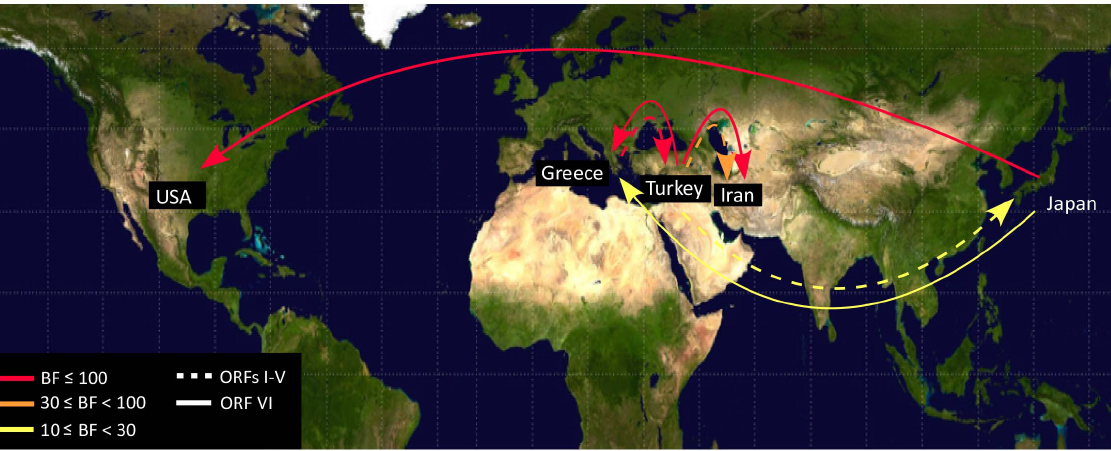
Figure 4. Patterns of Cauliflowermosaicvirus migration jointly estimated across the two ORF regions. ORFs I–V and ORF VI migrations are shown by solid and dashed lines. Lines connecting discrete regions indicate statistically supported ancestral state changes and their thicknesses denote statistical support. There are five categories of support. In increasing order, line thicknesses indicate 6 # BF , 10 (positive support); 10 # BF , 30 (strong support); 30 # BF , 100 (very strong support); and BF $ 100 (decisive support). Migration line was not shown when they were represented by only a single sample.